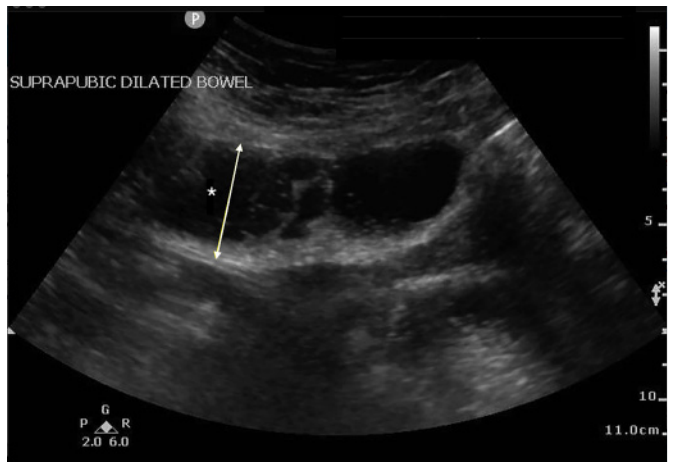
Image 1. Point-of-care ultrasound demonstrating long-axis view of dilated, fluid-filled loops of bowel (*) measuring 4.1 centimeters from outer bowel wall to outer wall, consistent with small bowel obstruction.